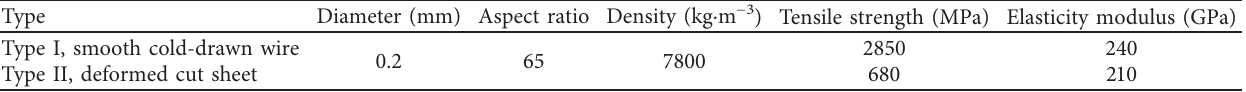
Table 4: . Properties of microsteel fibers.